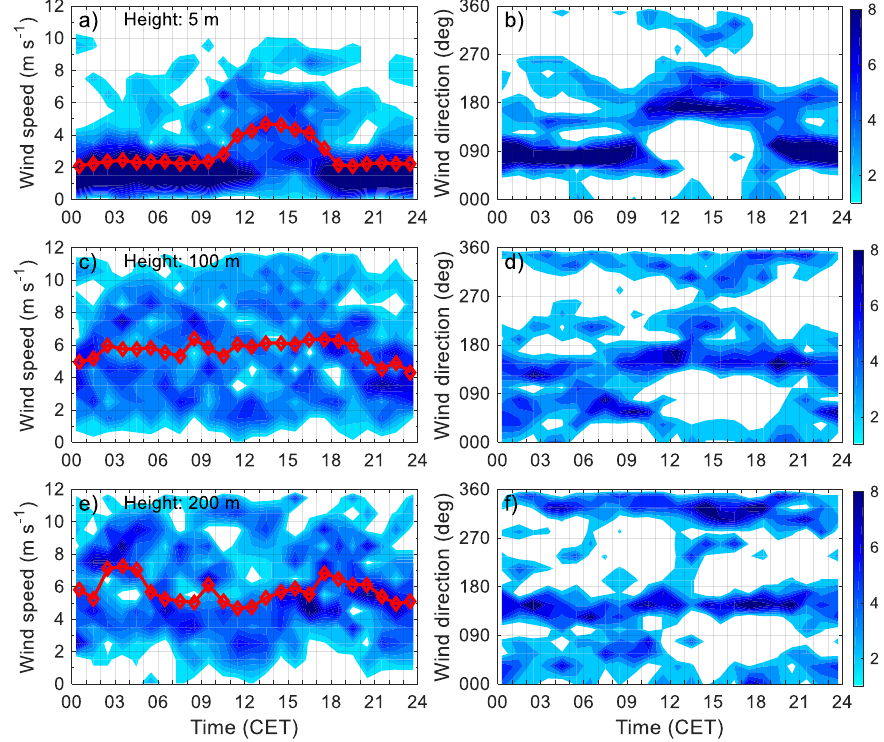
Figure 13. The same as Figure 12, but for the winter months December–February